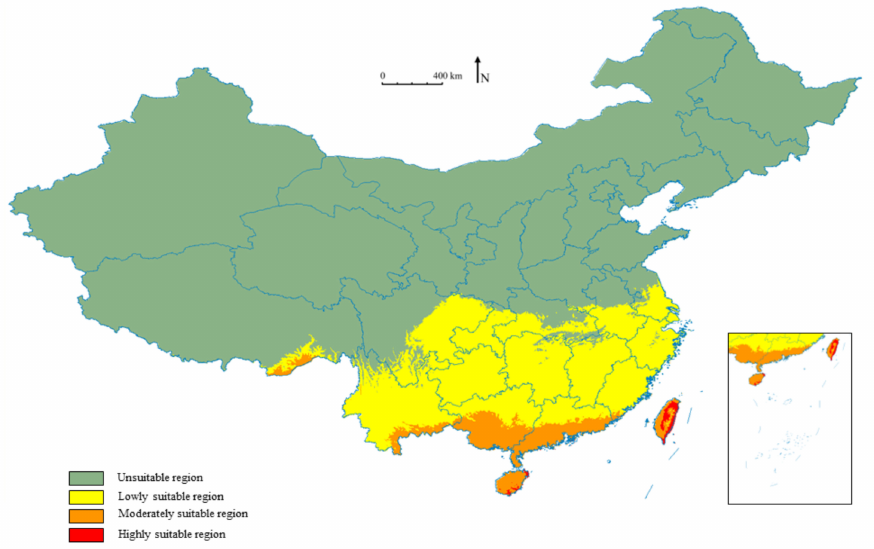
Figure 5. Potential distribution map of W. auropunctata in the current climate